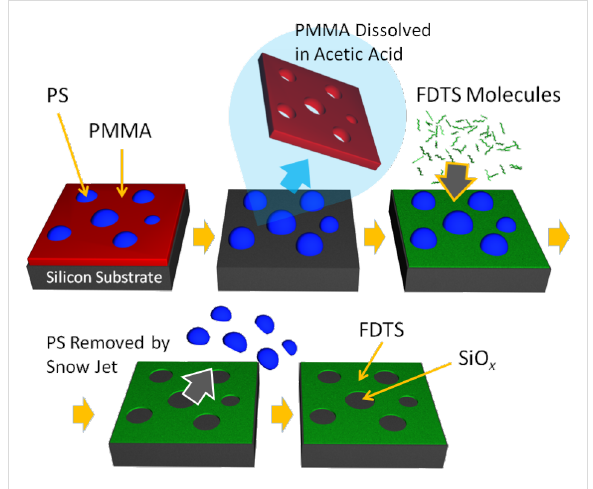
Figure 1: Schematic drawing of the polymer-blend lithography process. After spin-coating in a controlled atmosphere, a purely lateral morphology of PS droplets (blue) in a PMMA matrix (red) is formed. After the dissolution of PMMA in acetic acid, the PS droplets remain and can be used as a mask for the deposition of a fluorine-terminated SAM (FDTS/green). By a snow-jet treatment the PS droplets are selec- tively removed, and a patterned SAM is formed.